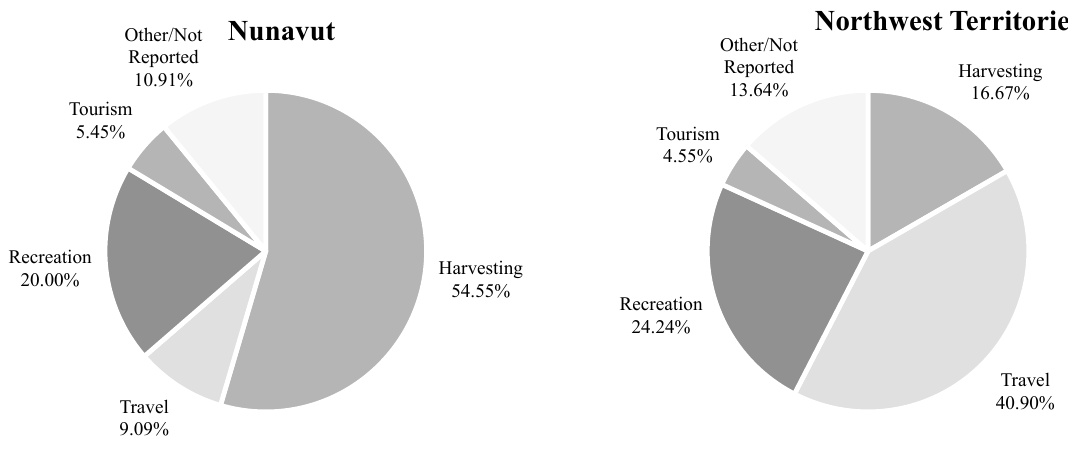
Figure 3. Reasons for being in the backcountry.